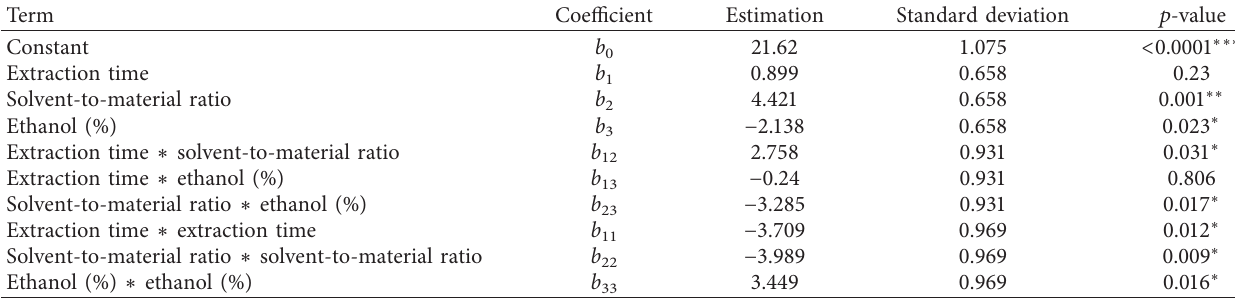
Table 4: Estimated regression coefficients for the yield response and their level of significance p value.